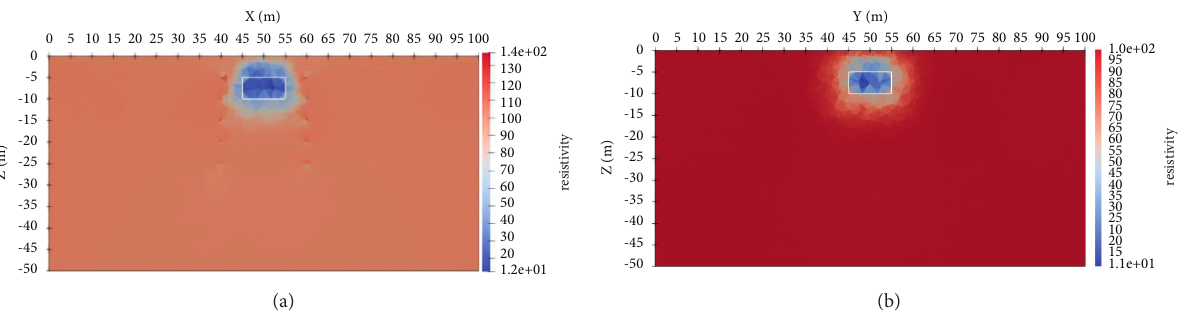
Figure 8: Inversion results of anomalous bodies under the flat surface. (a) Slice of resistivity inversion result at XOZ profile; (b) slice of resistivity inversion result at YOZ profile. The outline of the true model is indicated by the white